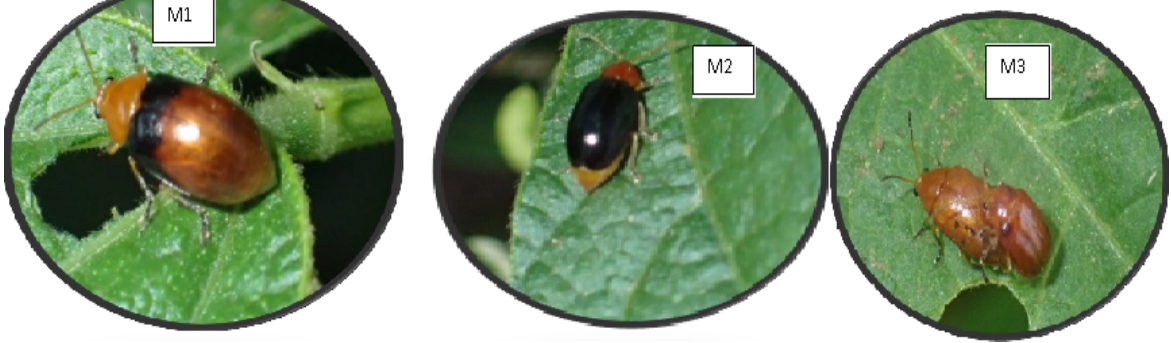
Figure 2. Different colourmorphs of Ootheca mutabilis. M1: O. mutabilis with elytra upper half black and lower half brownish; M2: O. mutabilis with black elytra; M3: O. mutabilis with brown elytra.